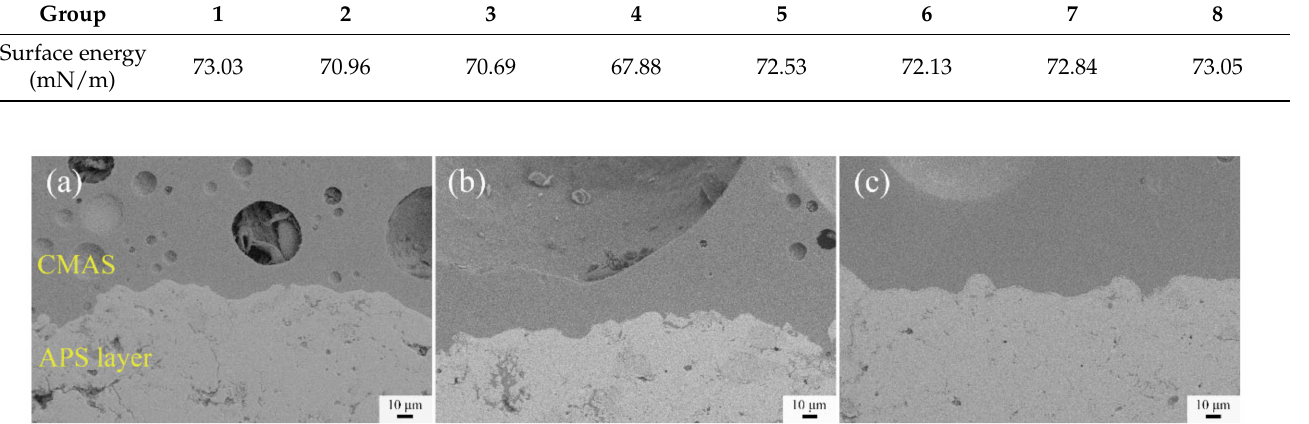
Figure 7. Interface between conventional APS coatings and CMAS after different times of heat treatment: ( a ) 180 s; ( b ) 300 s; ( c ) 600